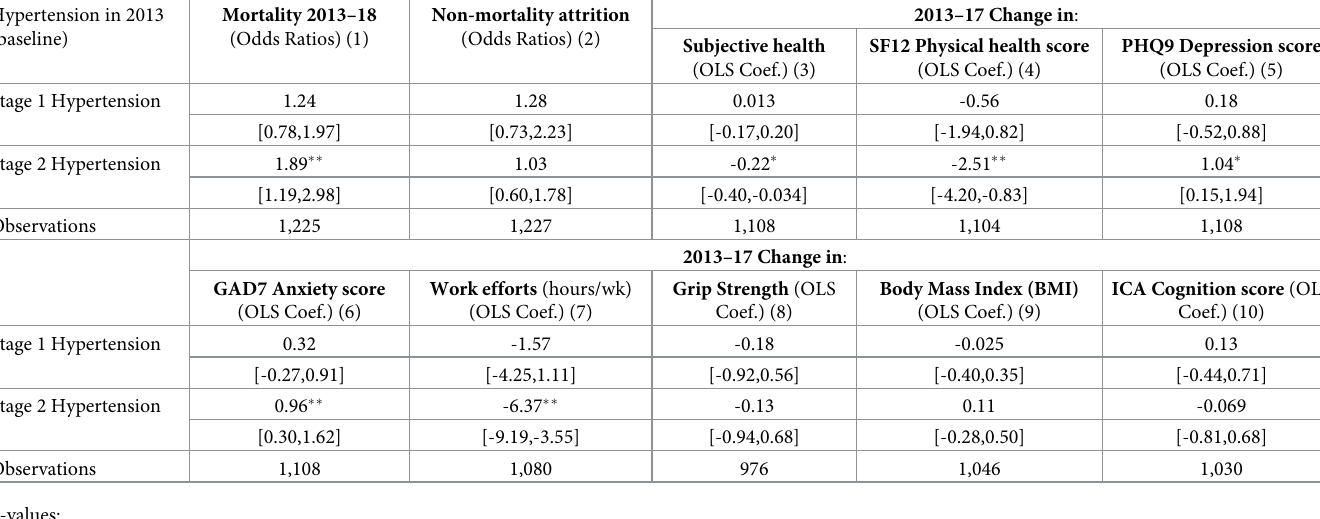
Table 4. Consequences of baseline hypertension in MLSFH-MAC cohort